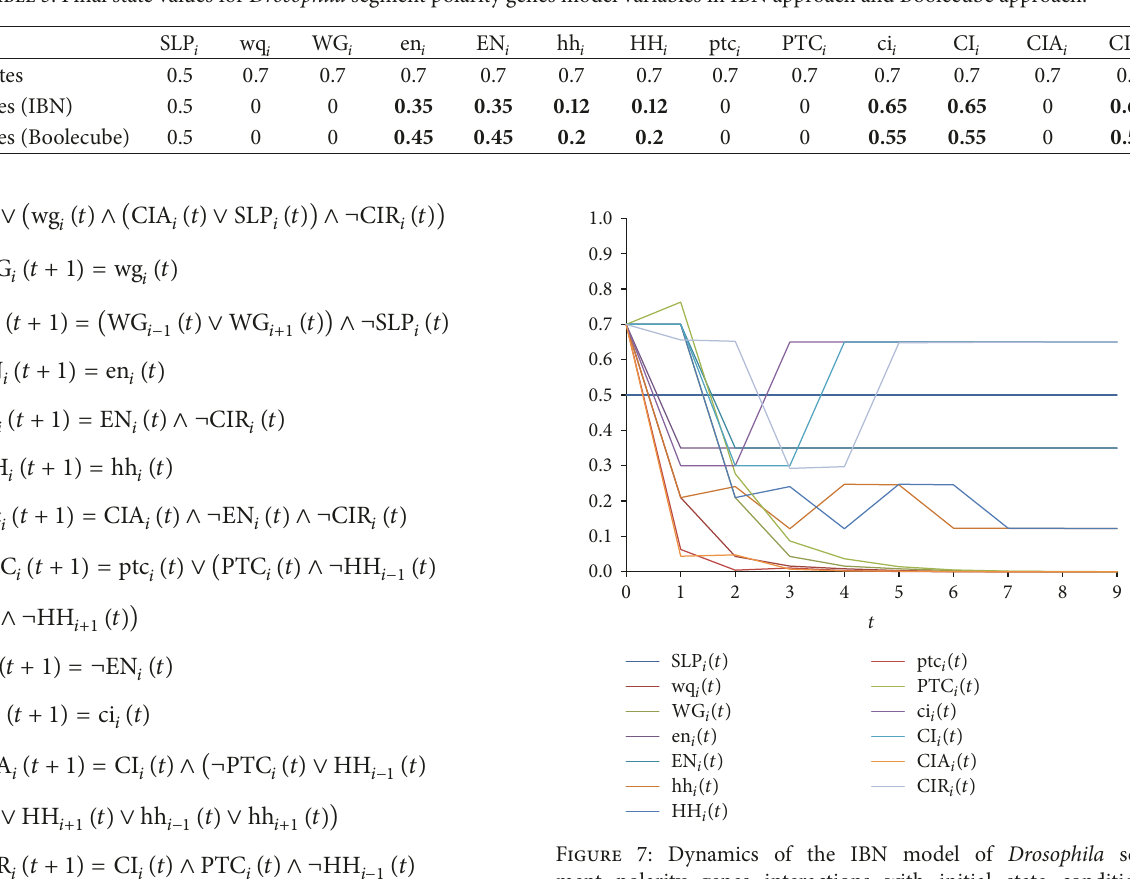
Table 3: Final state values for Drosophila segment polarity genes model variables in IBN approach and Boolecube approach.